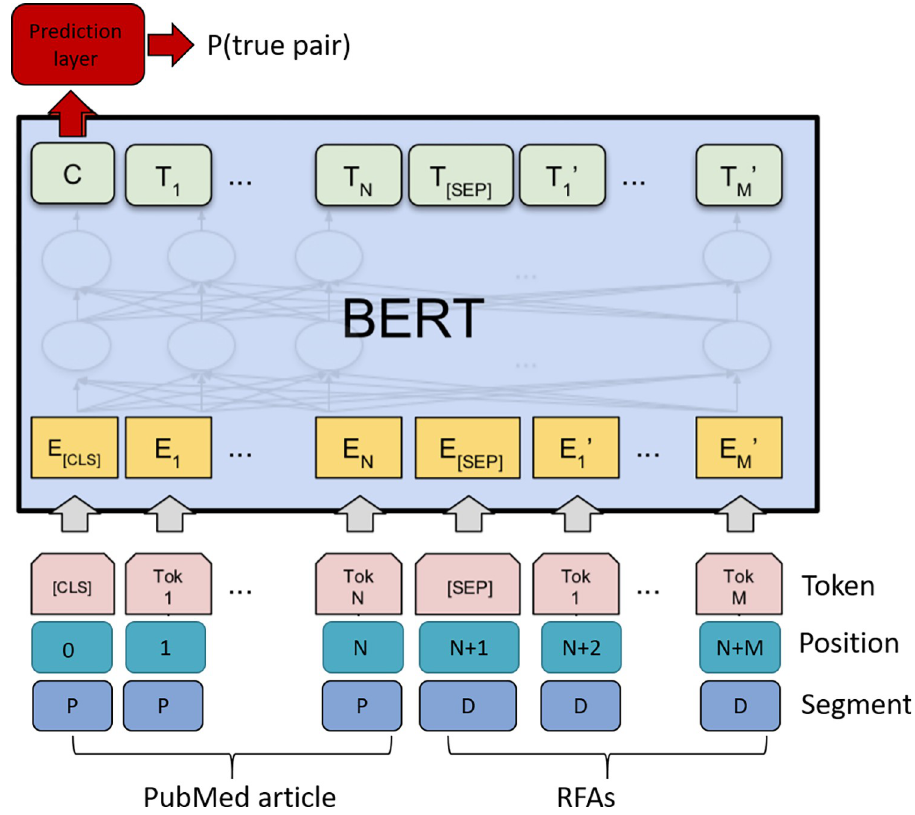
Fig 6. BERT usage in our